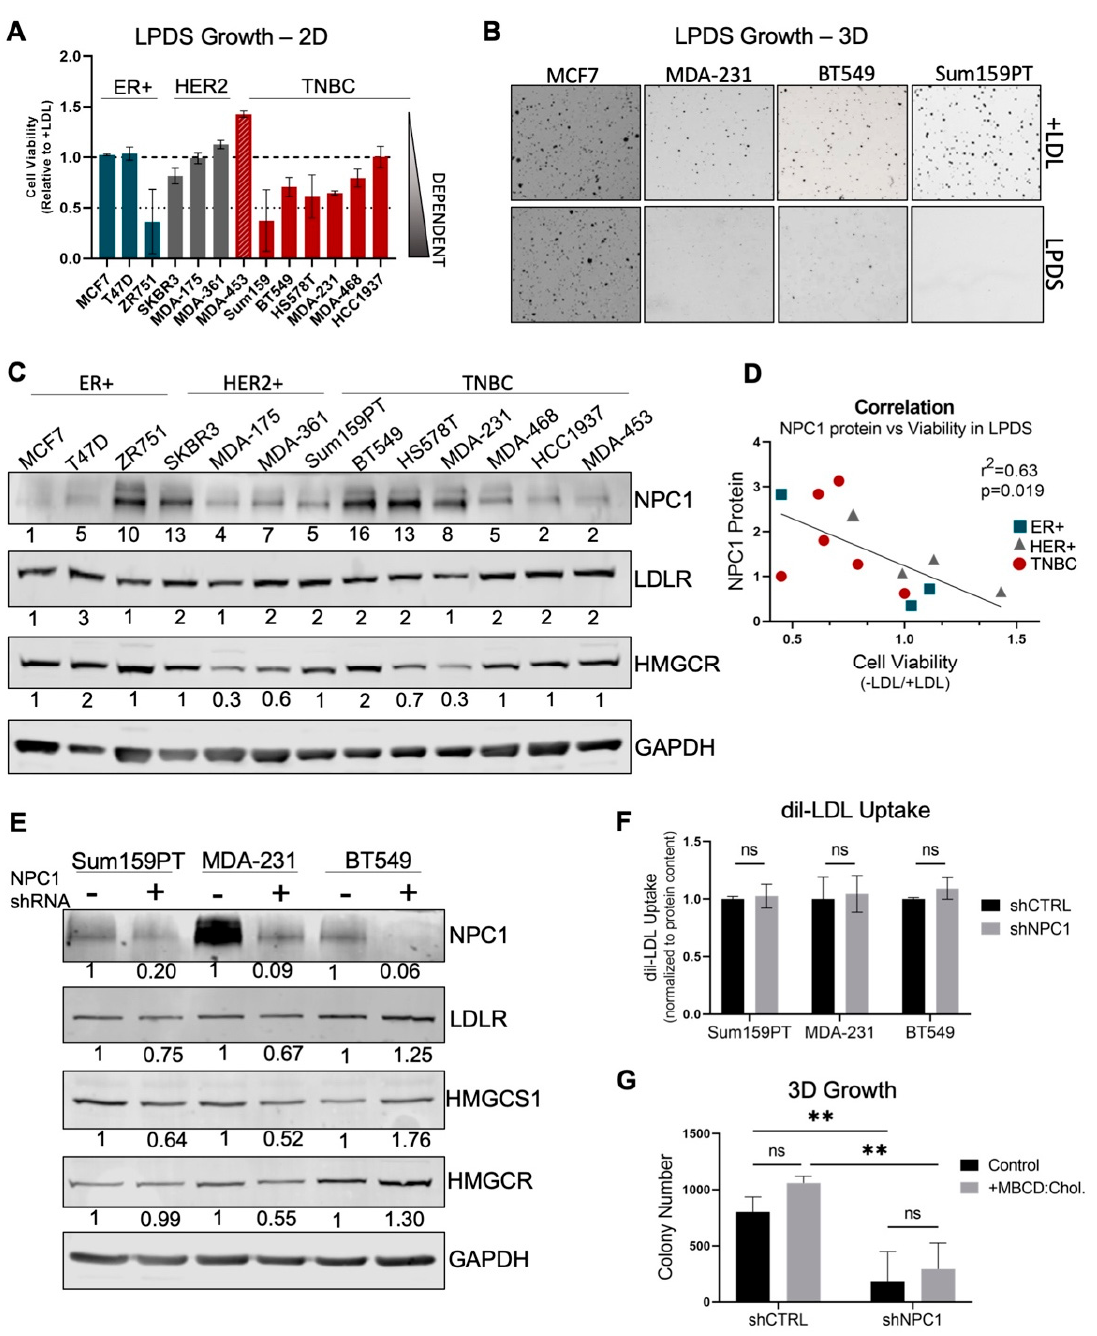
Figure 3. TNBC cells are cholesterol auxotrophs, but do not require NPC1 for adequate cholesterol supply. ( A ) Growth of breast cancer cell lines over 7 days in cholesterol-deplete (5% LPDS) relative to cholesterol-replete (5% LPDS + 10 µ g/mL LDL) media. ( B ) Colony formation in soft agar, cholesterol- deplete ( top ) and –replete ( bottom , 10 µ g/mL LDL); fourteen days. ( C ) Basal levels of key cholesterol metabolism proteins NPC1, LDLR, and HMGCR in a panel of breast cancer cells. ( D ) Correlation of NPC1 protein levels (quantified from western, 3C) to cell viability in LPDS (viability score from 3A). ( E ) Western blot of key cholesterol proteins in shRNA#1 cell lines. ( F ) Uptake of fluores- cent dil-LDL following 6 h of incubation, analyzed by a plate reader and normalized to protein content. ( G ) Growth of Sum159PT cells in soft agar when supplemented with MBCD:Cholesterol (1% M β CD complexed with 10 µg/mL cholesterol) over 14 days (Two-way ANOVA, Tukey Test). p -values denoted by asterisks where ** ≤ 0.01; or ns = not significant (>0.05).